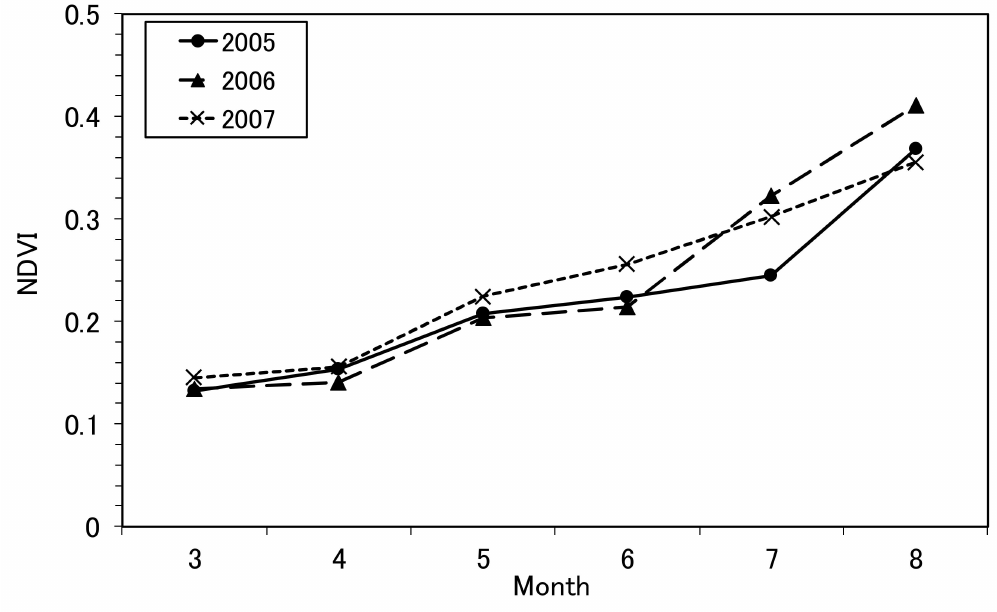
Figure 3. Monthly NDVI in Shenmu in 2005 to